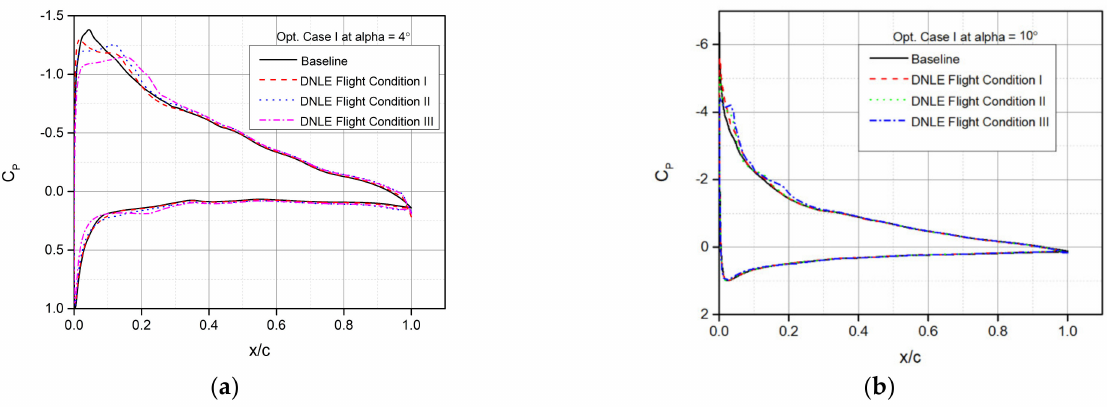
Figure 15. Pressure coefficients variations with the airfoil chord for Opt. Case I ( a ) at angles of attack of 4 ◦ ; ( b ) at angles of attack of 10 ◦